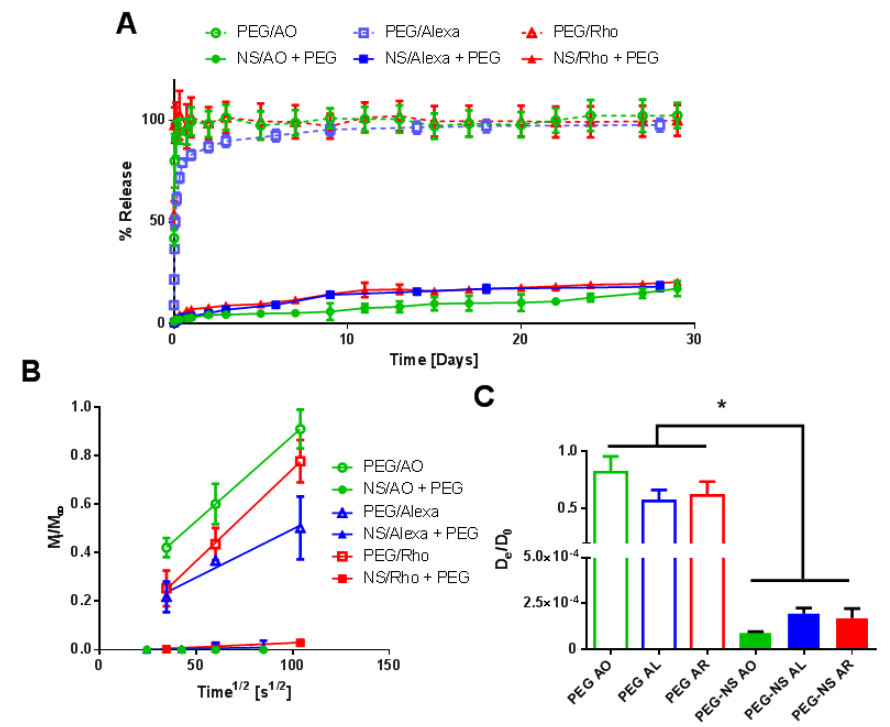
Figure 9. Release of varying model small molecules. ( A ) Bulk release of AO, Alexa, and Rho from hydrogels with 30 min incubation time and NS concentration of 0 mg/mL (PEG) or 1 mg/mL (PEG- NS). ( B ) Plot of fractional release as a function of the square root of time. ( C ) Calculated effective diffusion coefficient for each condition. * denotes statistically significant difference between all groups ( n = 4, p < 0.05) as indicated by an ANOVA followed by Tukey’s post hoc test.